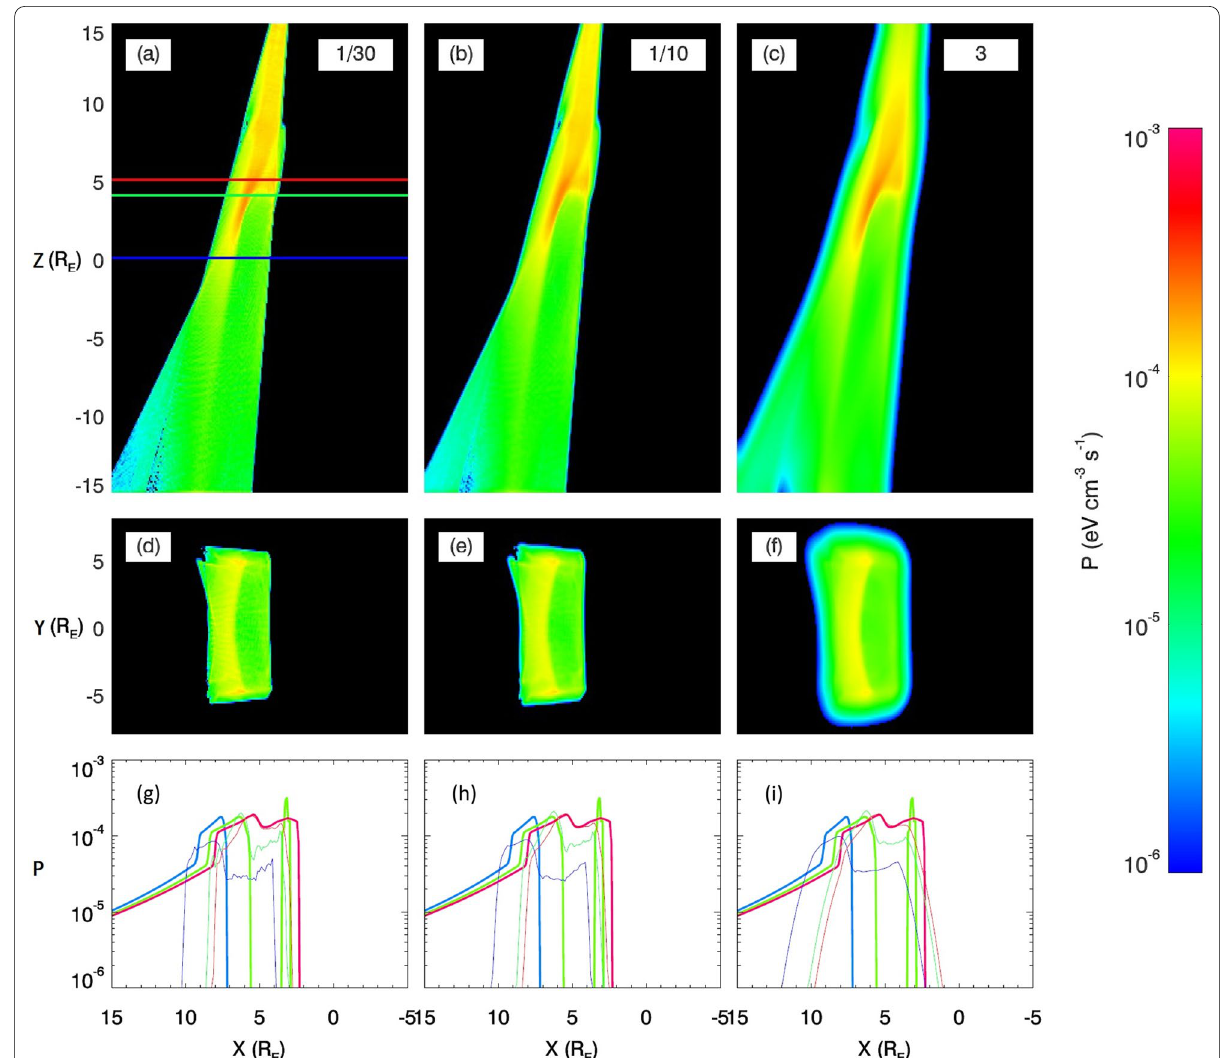
Fig. 9 Reconstruction using 100 images with ART and TV. Reconstruction using 100 images with ART and TV, for different number of TV iterations. The top row (panels a – c ) shows cuts along the XZ plane at Y row presents the linear cuts at the lines with Y reconstructed/MHD results. The first to third columns are results for 1, 3, 90 TV iterations every 30 ART iterations, respectively (Figure adapted from Jorgensen et al.